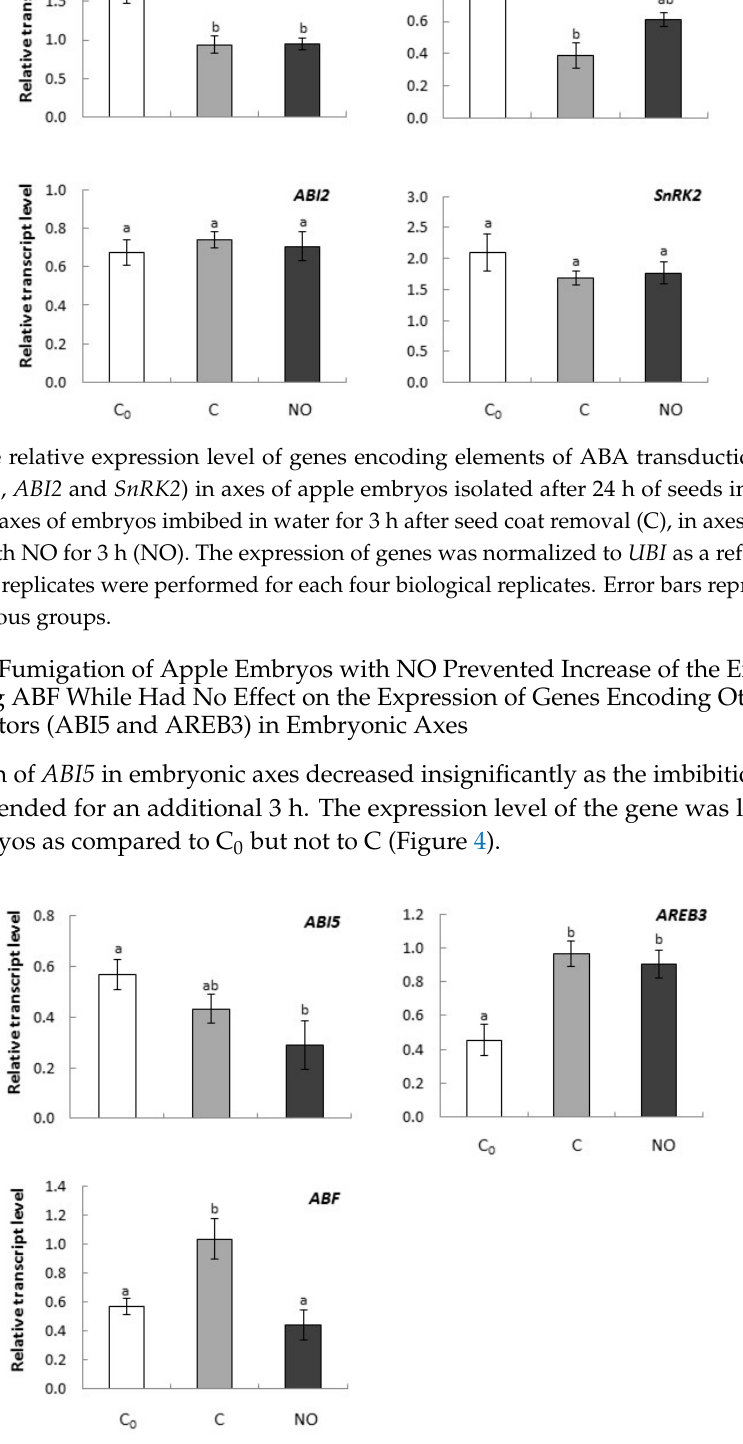
Figure 4. The relative expression level of genes encoding ABA transcription factors ( ABI5 , AREB3 , ABF ) in axes of apple embryos isolated after 24 h of seeds imbibition in water (C 0 ), in axes of embryos imbibed in water for 3 h after seed coat removal (C), in axes of embryos fumigated with NO for 3 h (NO). The expression of genes was normalized to UBI as a reference gene. Two technical replicates were performed for each four biological replicates. Error bars represent ± SD; a, b homogenous groups.